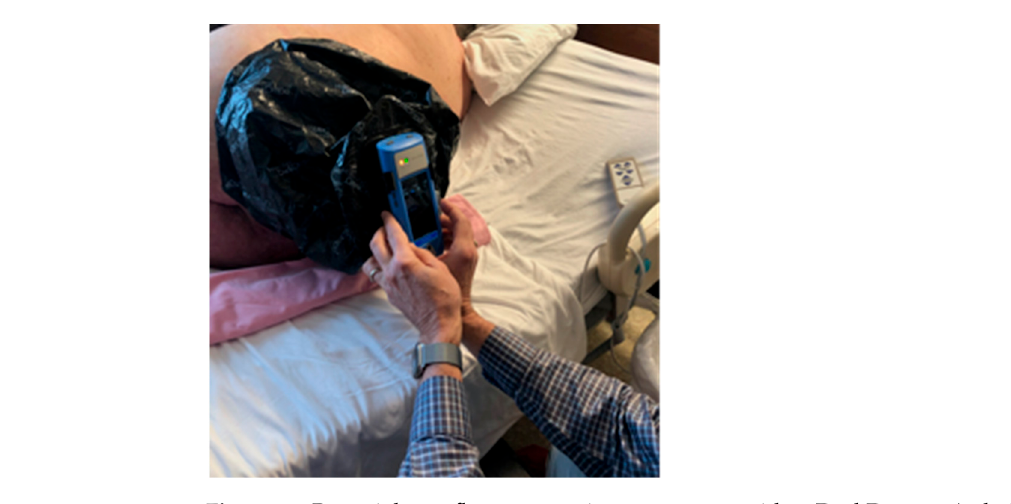
Figure 1. Bacterial autofluorescence image capture with a DarkDrape. A dark environment is required to capture interpretable fluorescence images. A DarkDrape is used when room lights cannot be turned off or other environmental conditions cause light contamination.